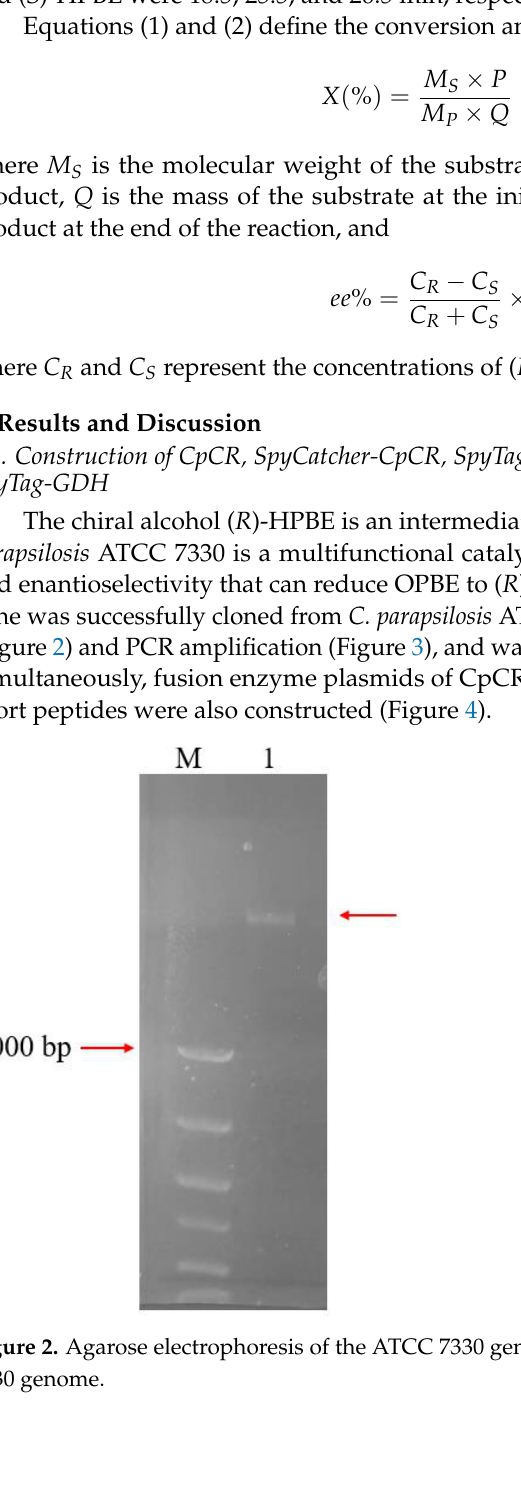
Figure 3. Agarose electrophoresis of colony PCR products. Lane M: DNA Marker. Lane 1: cpcr.